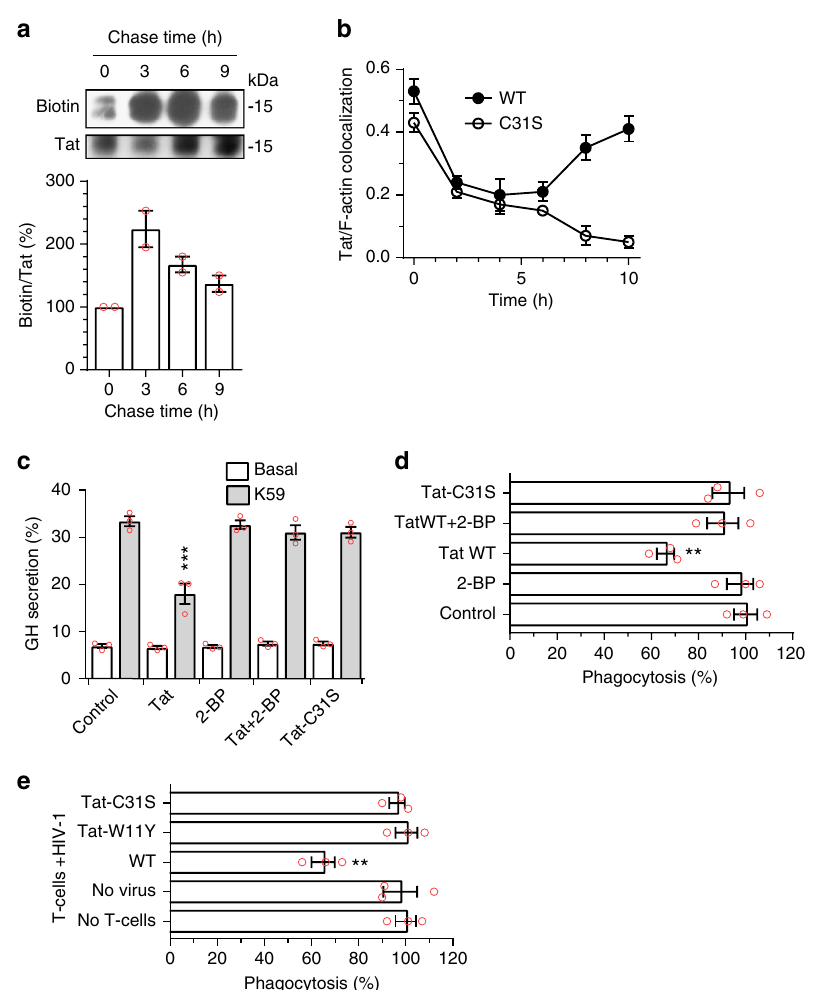
Fig. 4 Palmitoylation is a stable modi fi cation that enables Tat accumulation at the plasma membrane and Tat-mediated inhibition of PI(4,5)P 2 -dependent membrane traf fi c. a PC12 cells were labeled overnight with Tat-His 6 and 17-ODYA before chasing for the indicated times, cell lysis, Tat-His 6 puri fi cation and click chemistry. Results from a representative experiment are shown. The graph (mean ± SEM of 2 independent experiments) shows Tat palmitoylation ef fi ciency as the biotin/Tat ratio (% of the t0 value) as a function of time. The increase of labeling during the fi rst 3 h of chase is probably due to residual intracellular 17-ODYA. b PC12 cells were labeled with Tat (WT or C31S) at 4 °C before washing, chasing for the indicated times and Tat staining by immuno fl uorescence with F-actin labeling using fl uorescent phalloidin. Tat membrane localization was evaluated by quantifying Tat/F-actin colocalization using confocal images from 50 < n < 100 cells and Mander ’ s coef fi cient calculation. Mean ± SEM. Representative images are in Supplementary Fig. 10. c PC12 cells were transfected with human growth hormone (GH) then treated for 5 h with 100 µ M 2-BP, 20 nM Tat WT or Tat-C31S as indicated.